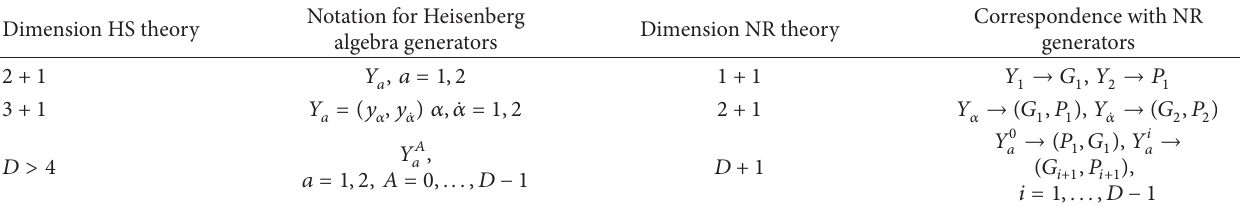
Table 1: The nonrelativistic covariance of Vasiliev’s higher spin theory can be made explicit by identifying the Heisenberg algebra generators 𝑌 ’s with the generators of Galilean boost and